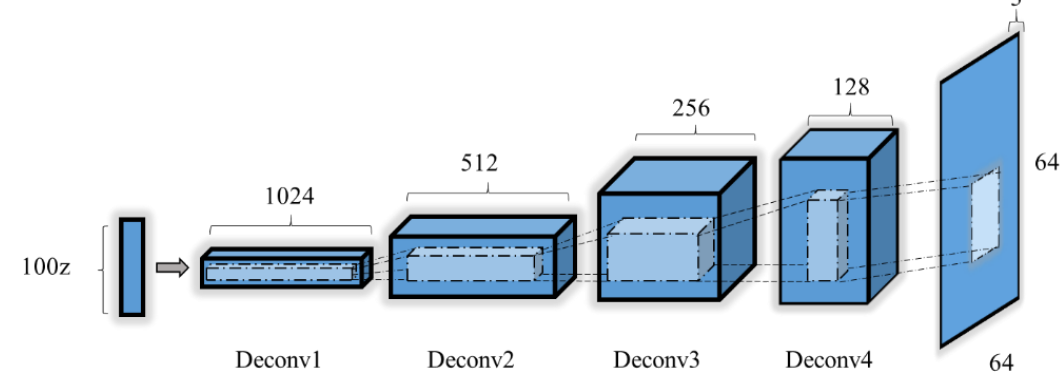
Figure 8. The structure of the generator.